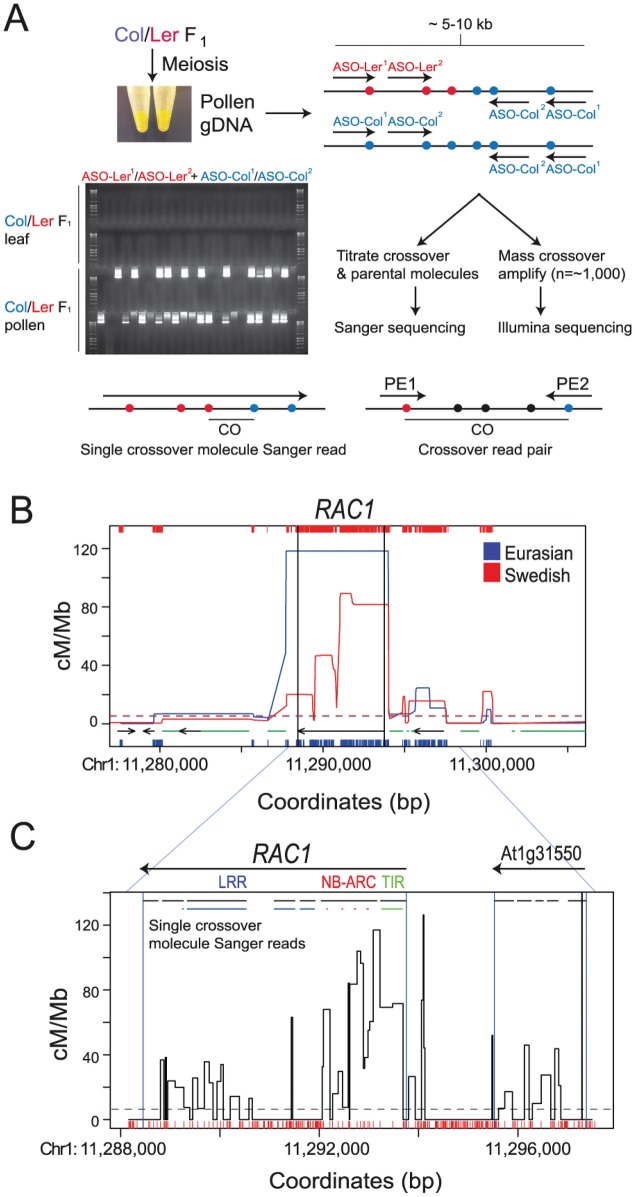
Intragenic crossover hotspots within the RAC1 resistance gene.(A) Diagram illustrating pollen-typing methods used to fine-map plant crossover hotspots. Pollen is collected from Col/Ler F1 plants and genomic DNA is used for two rounds of nested allele-specific PCR amplifications with either crossover (ASO-Ler+ASO-Col) or parental (ASO-Col+ASO-Col) allele-specific oligonucleotide (ASO) primer combinations. An ethidium-bromide stained agarose gel is shown with crossover-specific amplifications from Col/Ler F1 pollen, which are not observed when using Col/Ler F1 leaf (somatic) DNA as a template. Crossover positions are identified using either Sanger sequencing from single crossover molecule amplifications, or paired-end sequencing of crossover molecule libraries. (B) Historical crossover frequency over RAC1 estimated by LDhat analysis of polymorphisms from 80 Eurasian (blue) and 180 Swedish (red) accessions [72,73]. X-axis ticks indicate SNP positions used for analysis. Horizontal dotted lines indicate chromosome mean values. Black arrows represent genes and green horizontal lines indicate transposable elements. Black vertical lines indicate RAC1 TSS and TTS positions. (C) Crossover frequency within the RAC1 amplicon measured by crossover and parental molecule titration, followed by single crossover molecule Sanger sequencing. The positions of RAC1 and the adjacent gene (At1g31550) are indicated by horizontal black arrows above the plot. Exons are indicated by horizontal black lines, with sequences encoding RAC1 TIR (green), NB-ARC (red) and LRR (blue) domains highlighted as coloured lines. For the NB-ARC domain, the position of the Walker A, Walker B, ARC1 and ARC2 motifs are shown. Red x-axis ticks show Col/Ler SNP positions. Blue vertical lines indicate the positions of gene TSS and TTS from TAIR10 representative gene models.